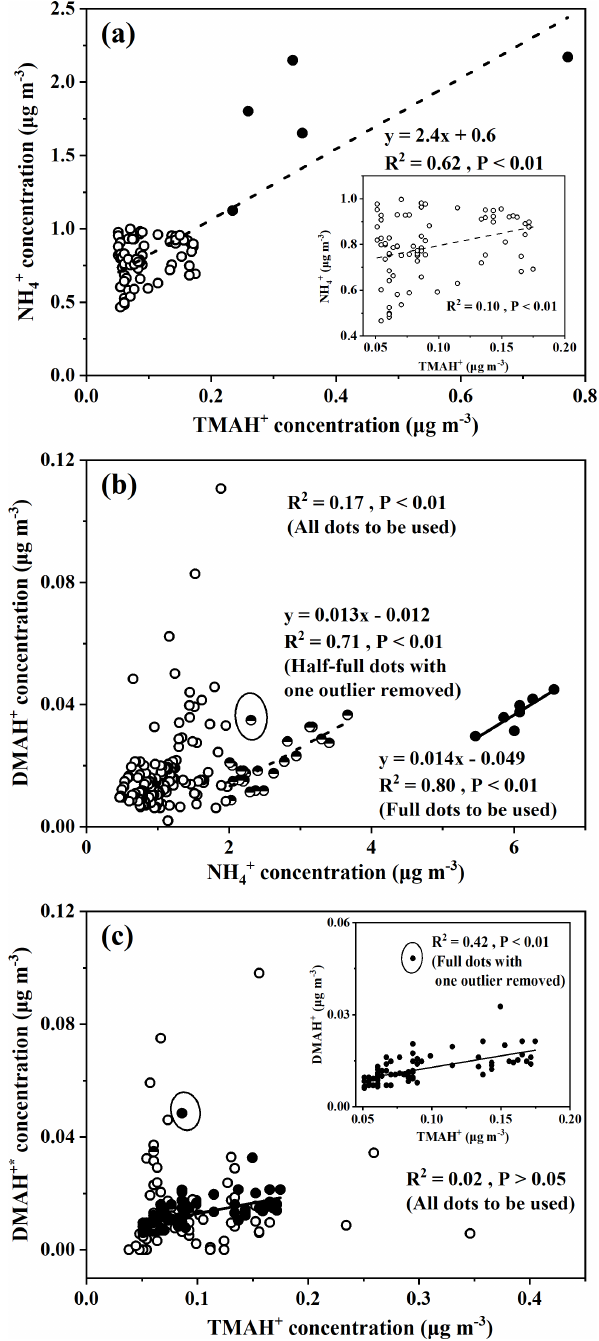
Figure 3. Correlations between concentrations of ions in PM 2 . 5 : (a) NH + vs. TMAH + and the samples when [NH + 4 in the inner frame; (b) DMAH +∗ vs. NH + TMAH + and the samples when [NH + frame. DMAH +∗ was defined in the text; full, half-full, and empty dots in (a) , (b) , and (c) are defined in the